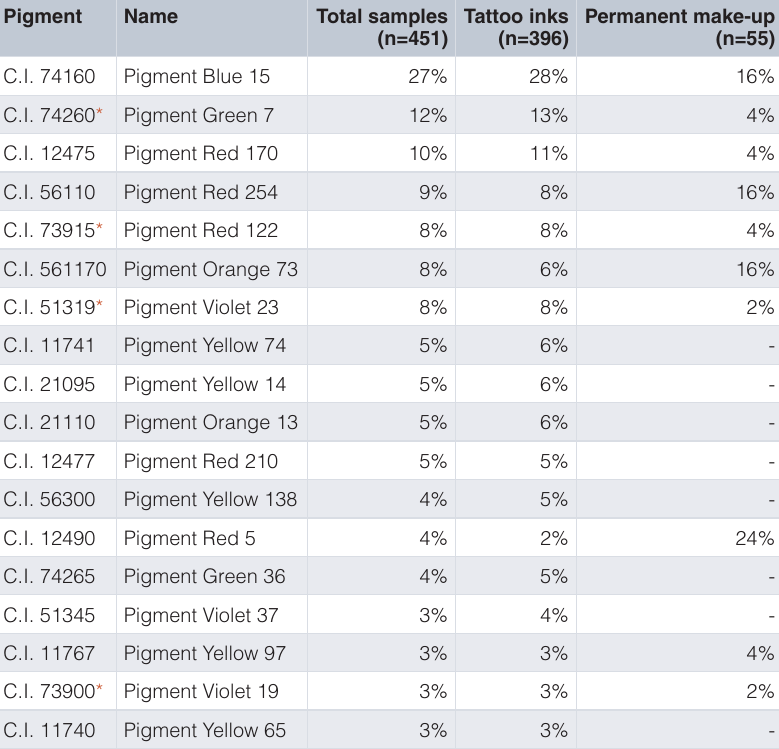
Table 1. Proportions of the most frequently identified pigments ( ≥ 2%) in about 450 products of Swiss market surveys between 2009 and 2017. Prohibited colours are marked with an